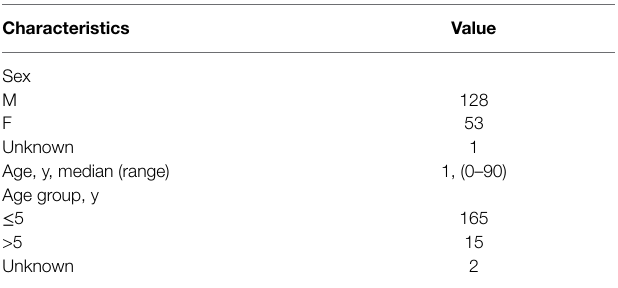
TABLE 1 | bla CTX-M -Positive S. Typhimurium isolates collected from patient demographics characteristics, Guangdong, 2010–2017 ( N = 182).